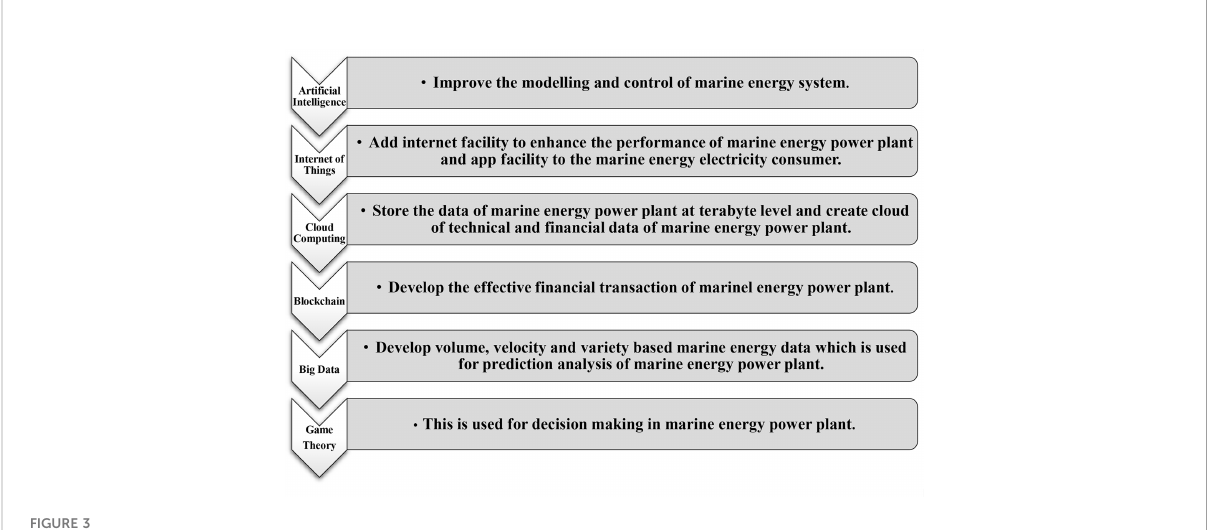
FIGURE 3 Application of Recent Trends in Marine Energy System.